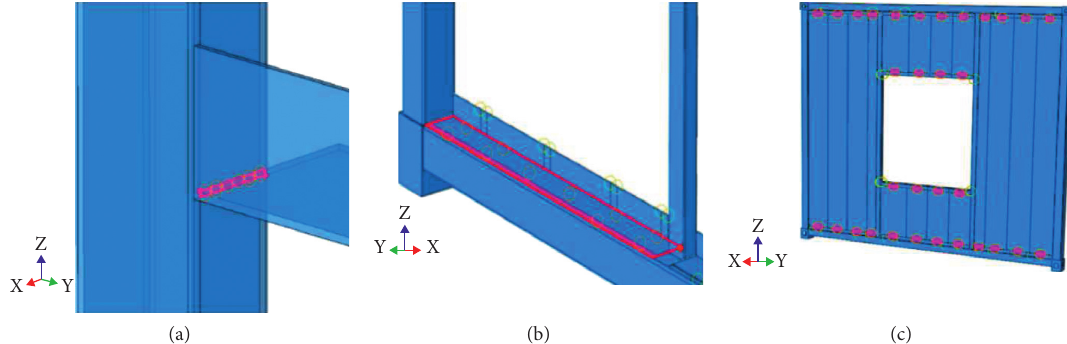
Figure 10: Binding forms of QX-1. (a) Surface binding of angle steel by the window. (b) Surface binding of end angle steel. (c) Point binding for bending plate.